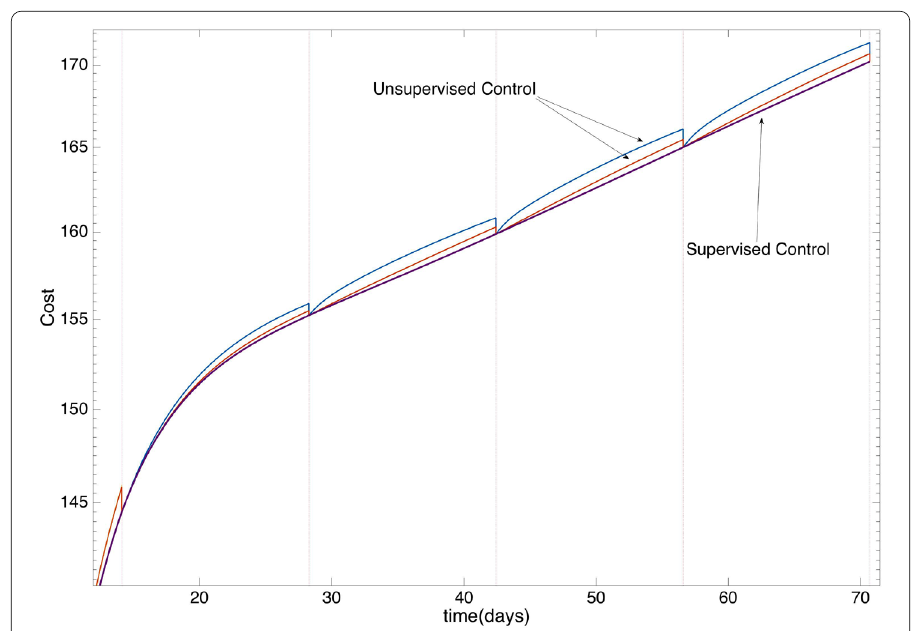
Figure 10 Costs under supervised and unsupervised controls